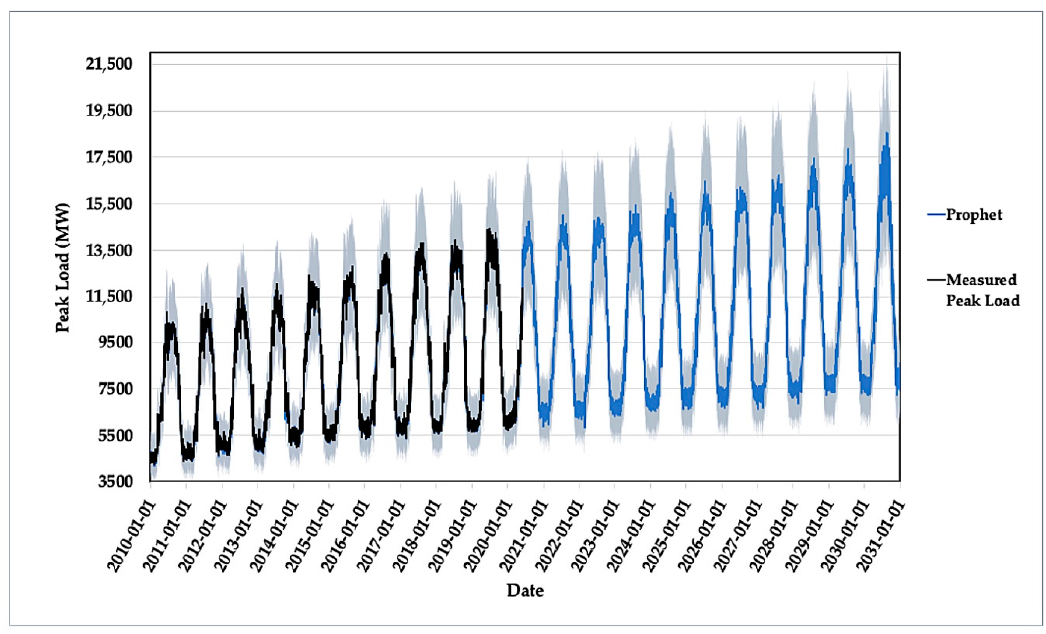
Figure 4. The measured peaks of daily loads data in Kuwait: the trained, predicted, and forecasted data using the Prophet model with a 99% confidence interval.